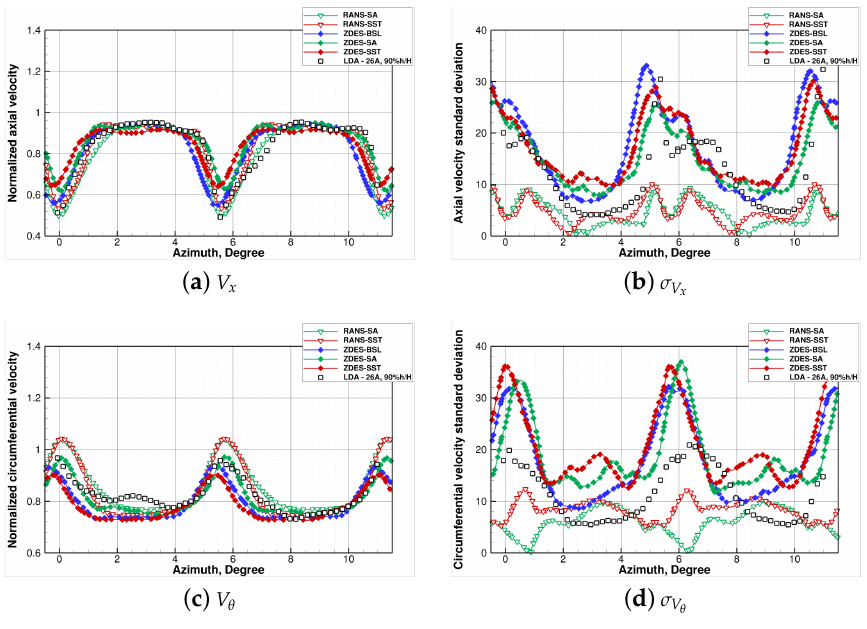
Figure 7. Axial ( V x ) and circumferential ( V θ ) components of velocity V and their respective standard deviations σ